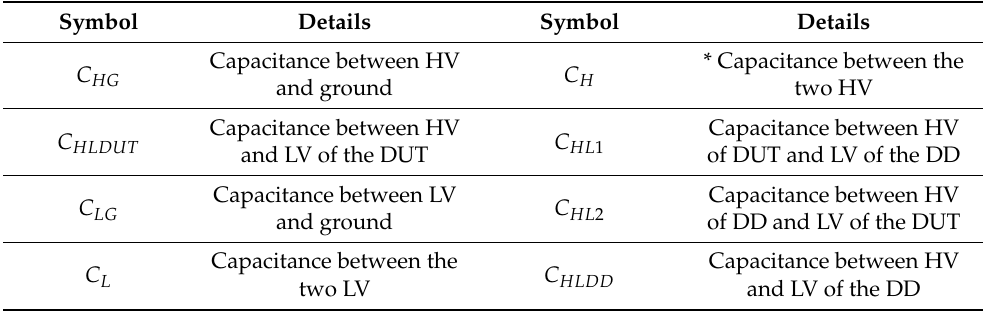
Table 1. List of SCs and their meaning.